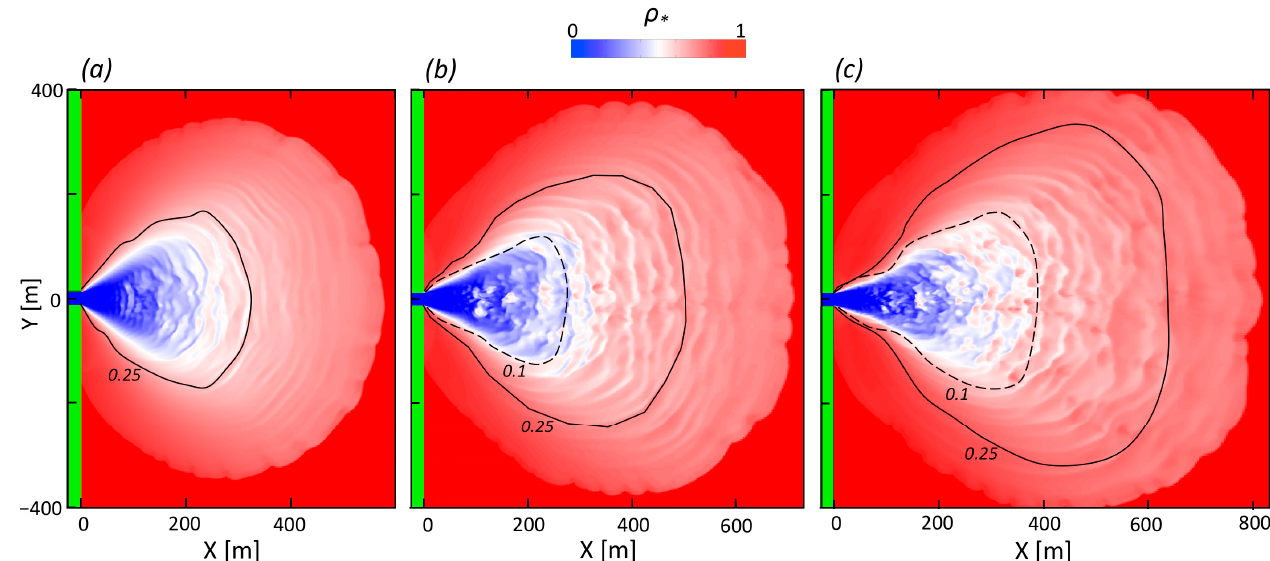
Figure 7. Variation of plume morphology with inflow velocity U 0 . (a) U 0 = 1.0 m s − 1 ; (b) U 0 = 1.5 m s − 1 ; (c) U 0 = 2.0 m s − 1 . Corresponding values of river discharge rate are 42, 62, and 83 m 3 s − 1 ; values of inlet Froude number are 2.0, 2.9, and 3.9. Curves indicate values of Richardson number of 0.1 and 0.25; panel (a) has no 0.1 or lower values. Model time is 1630 s for each case.